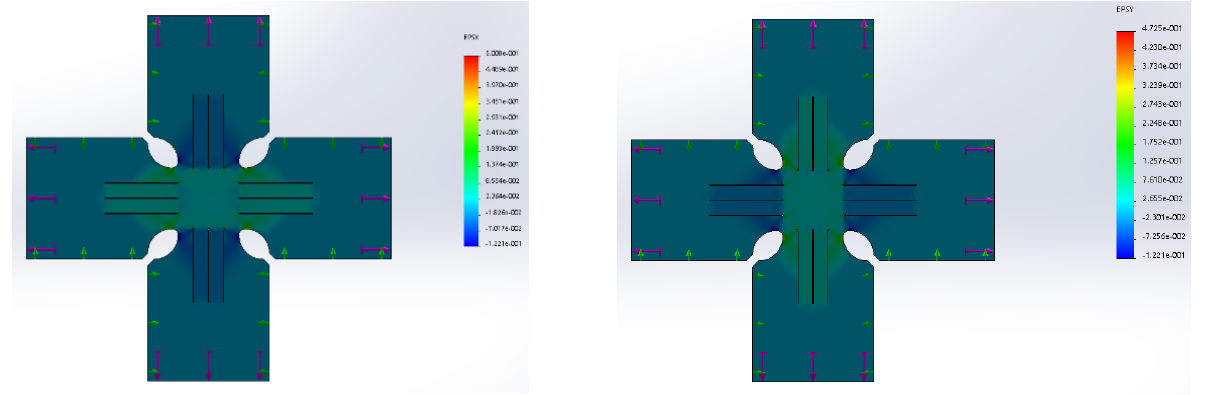
Figure 30. Typical strain distributions for the force ratio Fx:Fy = 1 in the final step of the simulation. Purple arrows show the direction of the load; green arrows show the virtual action of the slider.